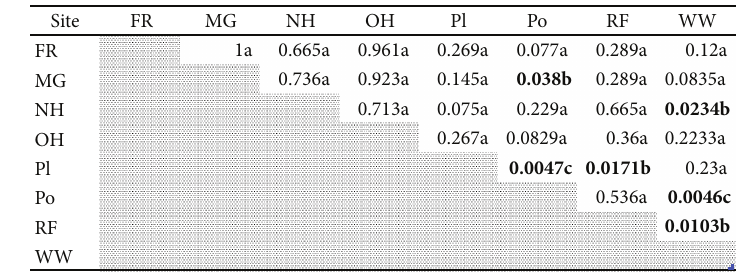
Figure 5: Comparison of Mann Whitney Statistical test 𝑃 value results for Shannon diversity score between sites. Significant differences are highlightedinbold,anddifferencesinsignificancethresholdarehighlightedbyadifferentletter.FlowerRichGrassland(FR),MownGrassland (MG), New Hedge (NH), Old Hedge (OH), Plantation Woodland (Pl), Pond (Po), Ridge and Furrow Grassland (RF), and Woodhorn Woodland (WW).